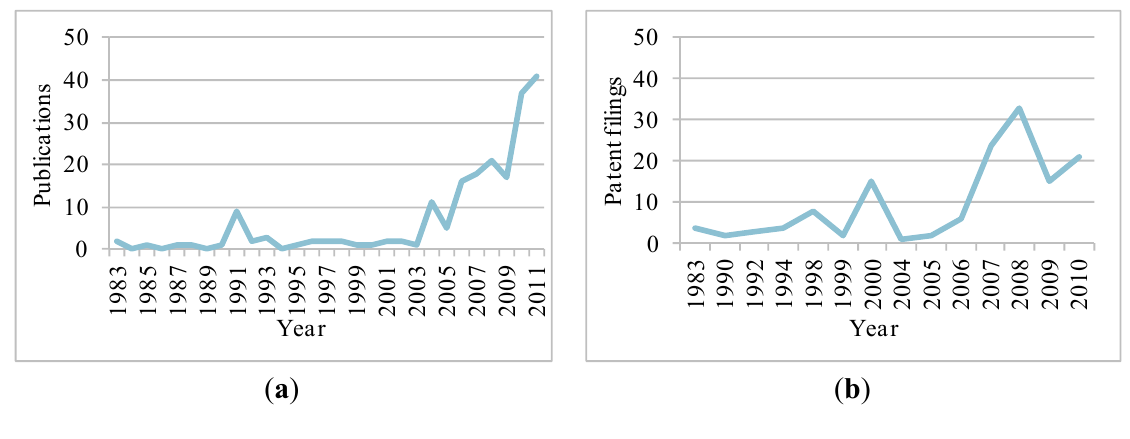
Figure 2. ( a ) Gas fermentation-related academic literature versus time (SciVerse